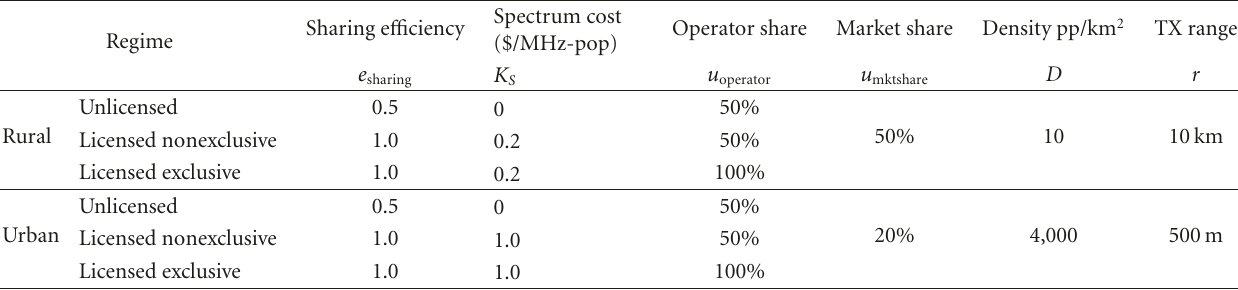
Table 5: Regime-dependent input variables.